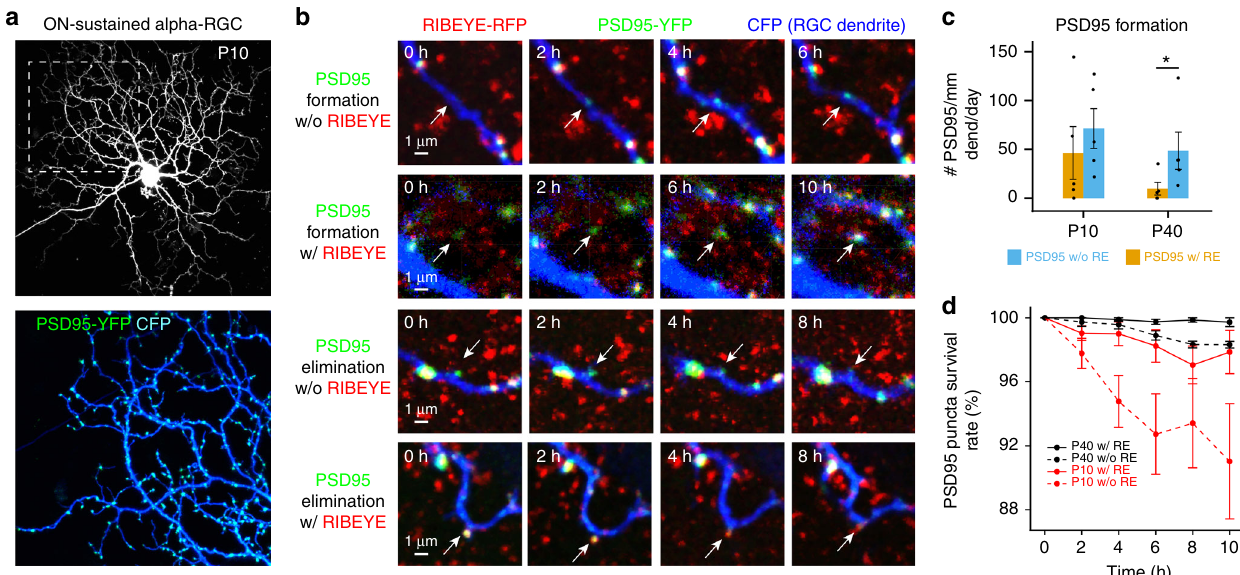
Fig. 5 PSD95 puncta are more stable when apposed to ribbons. a RGCs were biolistically labeled with CFP together with PSD95-YFP. Live-cell imaging: every 2 h, up to 10 h. b From top to bottom: An example of PSD95 formation with (w/) or without (w/o) RIBEYE-tagRFP-T and PSD95 elimination with or without RIBEYE-tagRFP-T puncta. c The rate of PSD95 puncta formation with and without RIBEYE-tagRFP-T puncta at P10 and P40. d Survival rate of PSD95 puncta with and without RIBEYE-tagRFP-T puncta at P10 and at P40. Five live imaging experiments are performed at both P10 ( fi ve cells from four retinas) and P40 (four cells from two retinas). Data are presented as mean ±